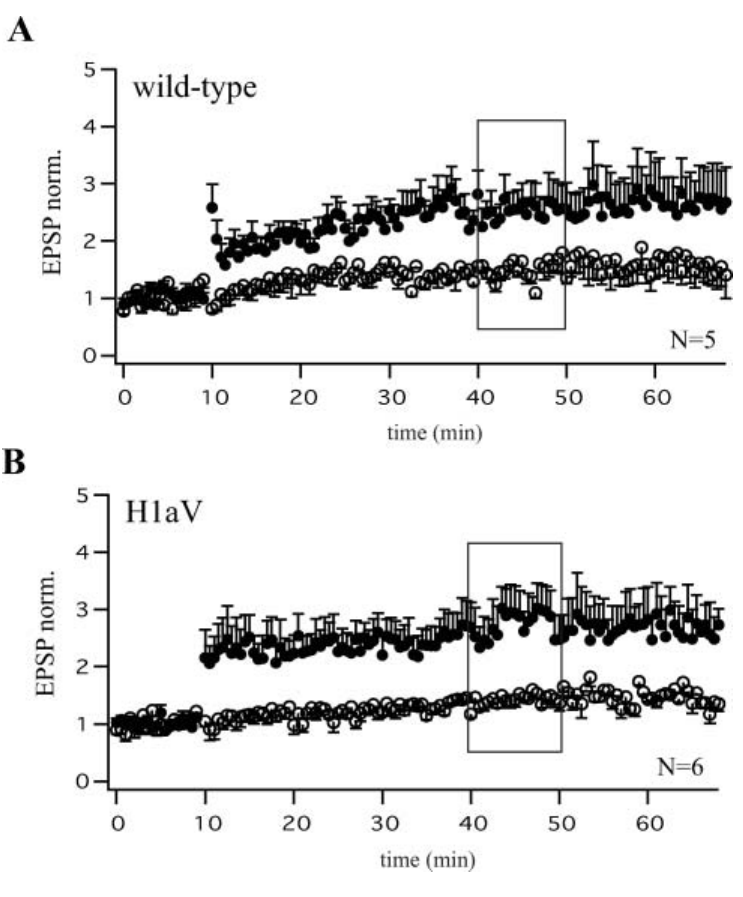
Figure 3. Comparable levels of CA3-CA1 LTP after Dox treatment of wild-type and Tg H1aV.Fb mice . Theta-burst pairing (TBP) induced comparable levels of LTP as quantified 40minutes after induction (black boxes A , B ) in CA1 pyramidal cells of dox-treated wild-type ( A , N=5 cells from three mice) and TgH1aV.Fb ( B , N=6 cells from three mice) animals measured at P56. Both, wild-type and TgH1aV.Fb mice were supplied with dox (0.1g/l) in the drinking water, from P42 until